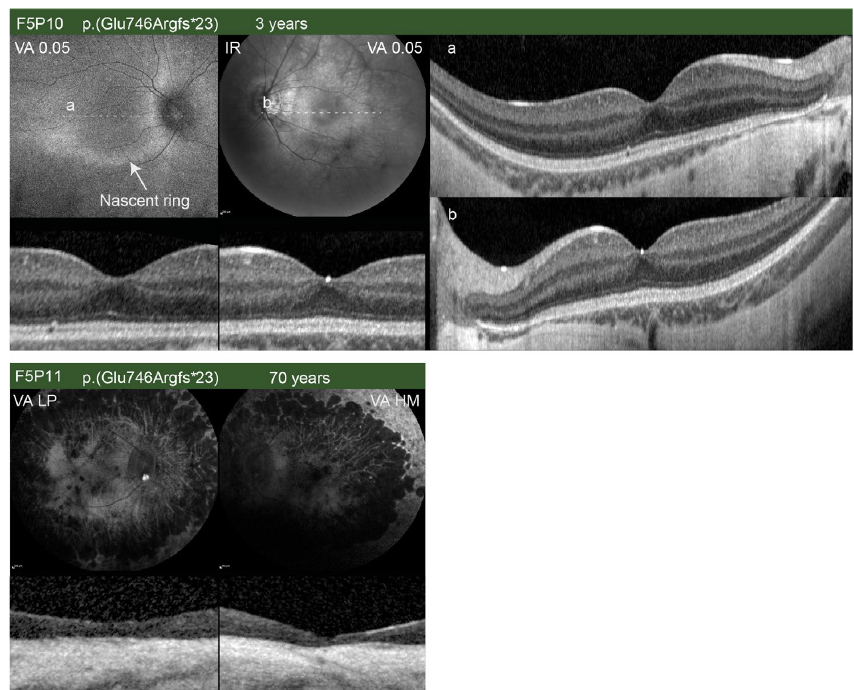
Figure 5. FAF and central OCT of male RP patients from family 5. Wider OCT is marked with white dashed line and shown on the right ( a , b ). Note the hyperautofluorescent border on the FAF of the right eye of the 3-year-old patient (F5P10), which likely represented a nascent FAF ring (arrow).